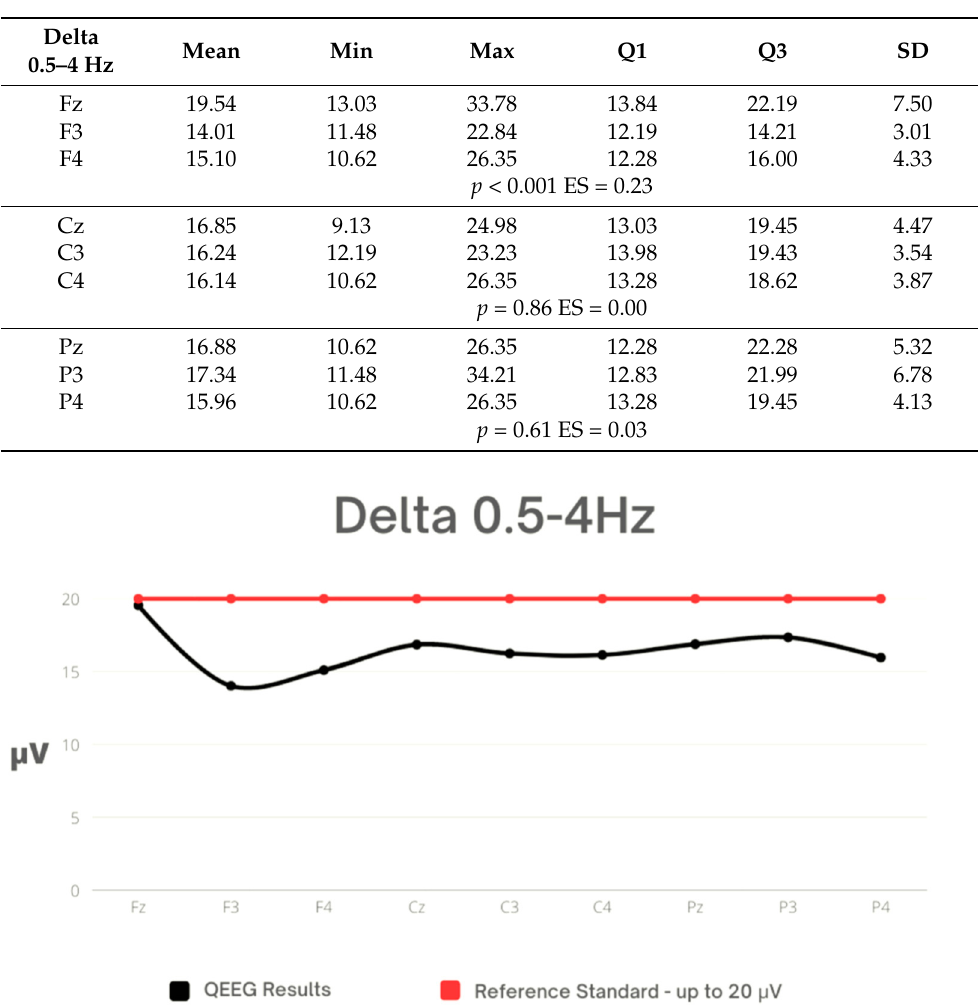
Figure 1. Mean values for Delta against the reference standard.